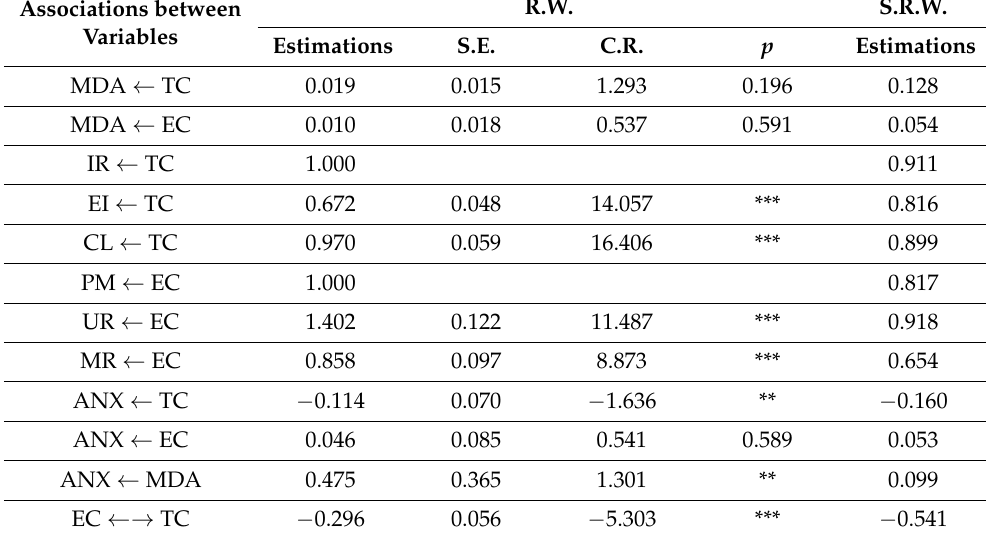
Table 3. Structural model for participants showing a medium level of weekly PA.